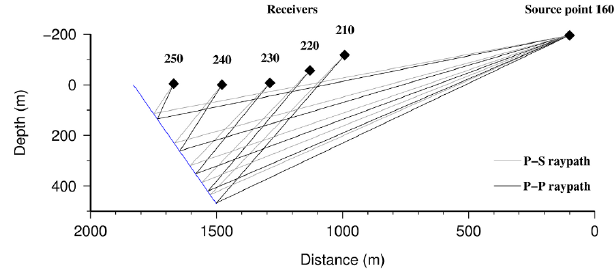
Fig. 11. 2-D sketch of the selected ray paths for a model with a plane dipping 55 ◦ . The angle of reflection is larger than the incidence angle for the P-S converted ray path, since the S wave velocity is lower than the P wave velocity. The reflection point for receiver 210 is located at approximately 425m depth for a P-S converted reflection.